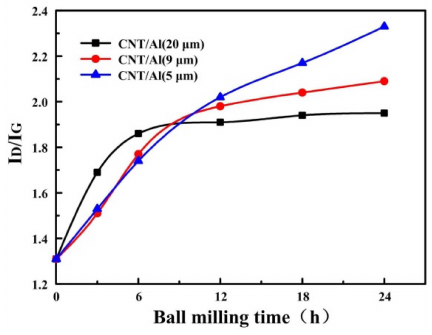
Figure 8. ID/IG ratio of the milled composites powders various with ball milling